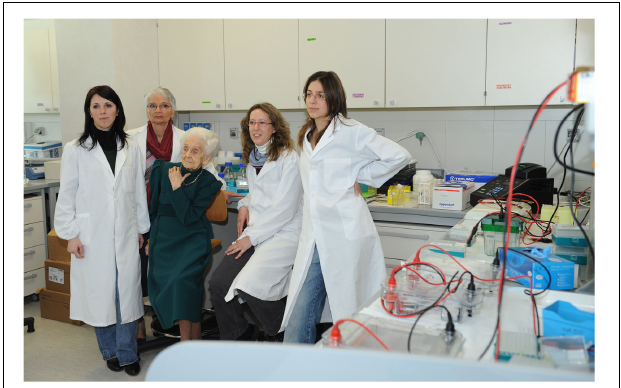
FIGURE 2 | Rita Levi-Montalcini in the laboratory with her group. From left to right: Annalisa Manca, Anna Di Luzio, Francesca Paoletti and Francesca Malerba [Photographer Maurizio Riccardi (Agr Press) from EBRI Media Archive].